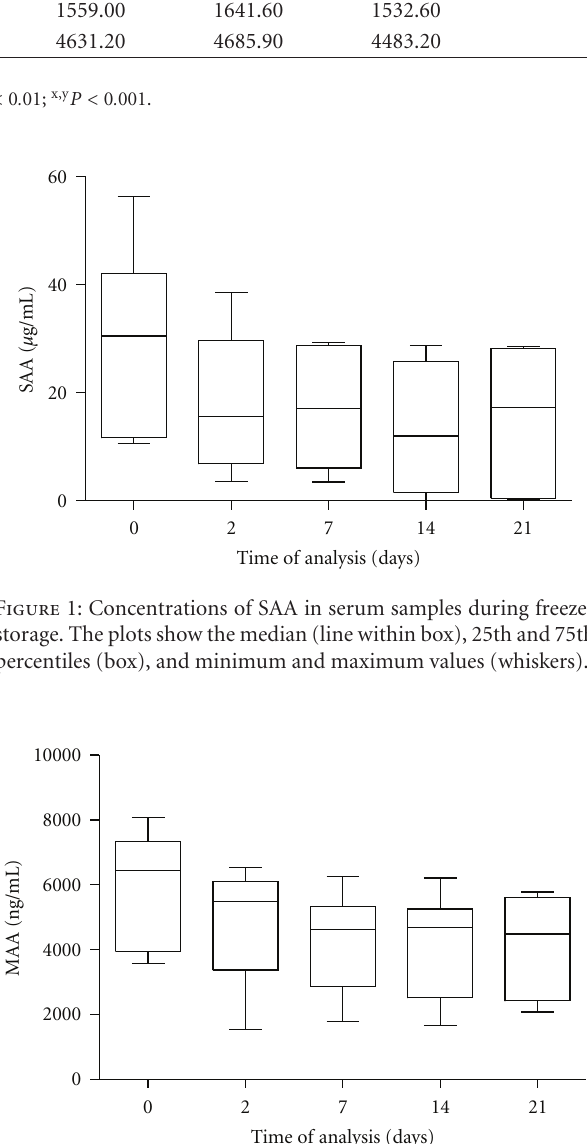
of measured values ranged from 3936 to 7326 ng/mL, and in samples analyzed on day 2 of storage we already recorded lower concentrations with the range of 50% of measured values between 3371 and 6091